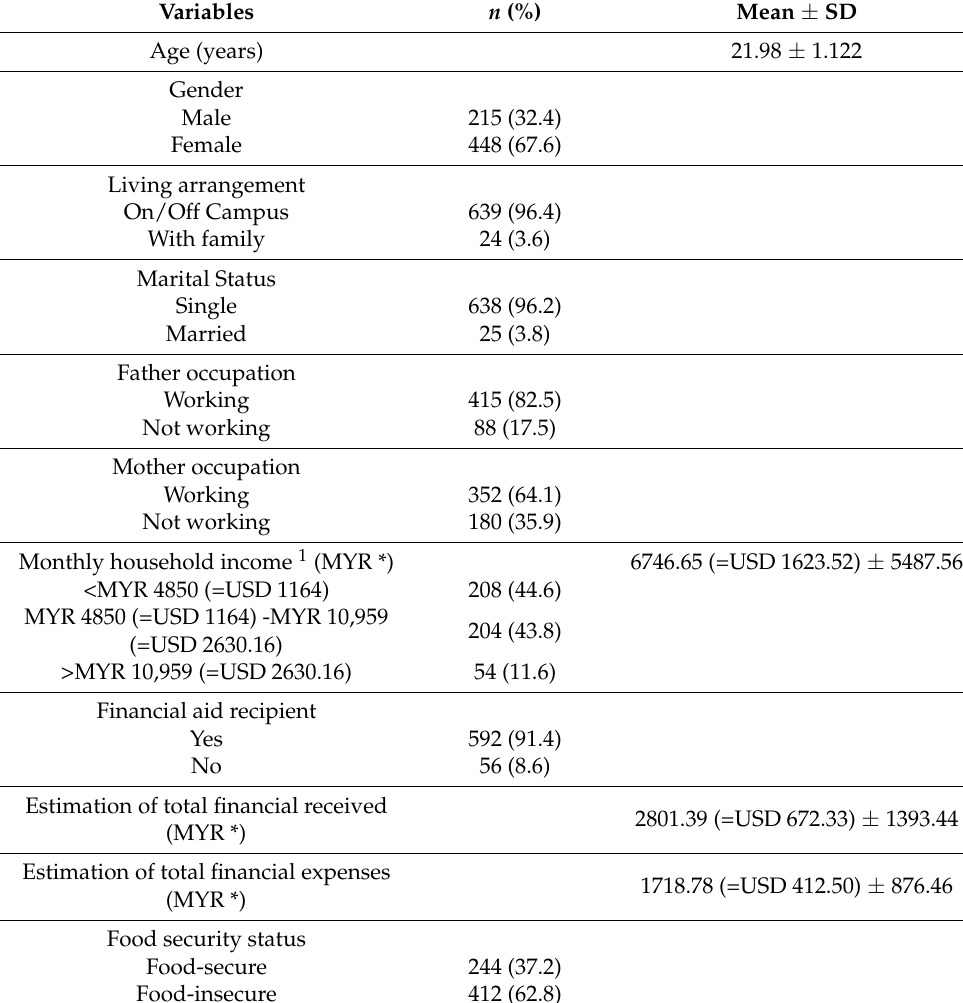
Table 1. Characteristics of